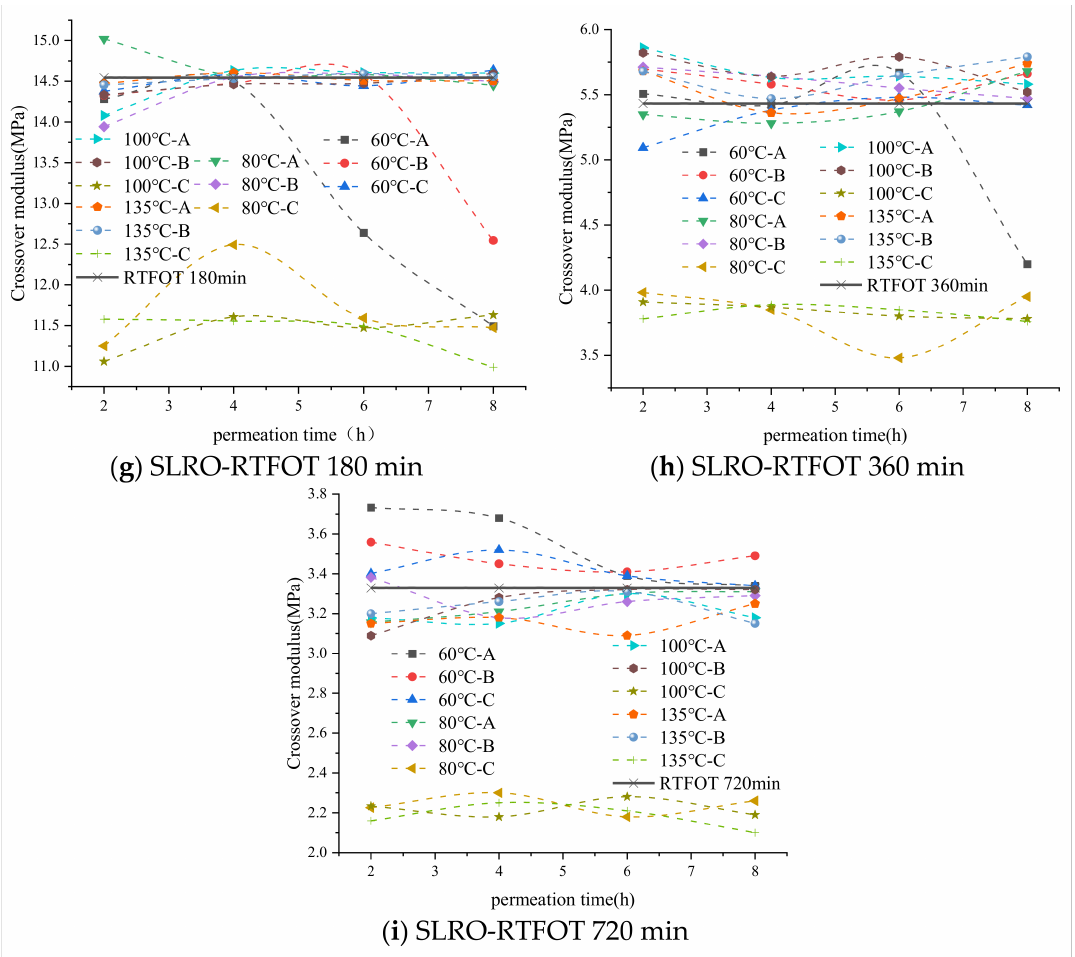
Figure 17. The crossover modulus of PFL varies with temperature and